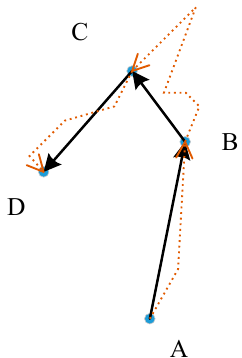
Figure 1. The potential location and path of an animal.